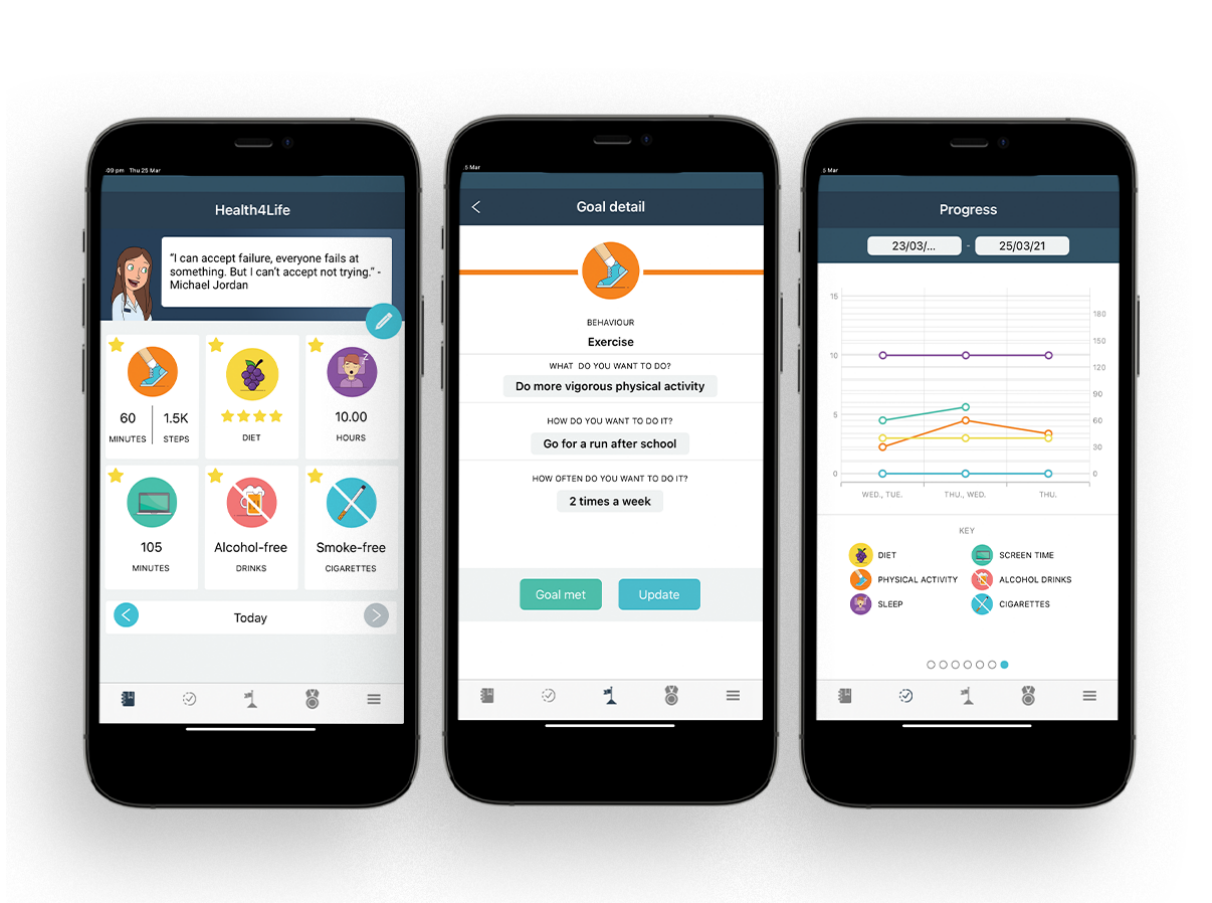
Figure 1. Selected screenshots of the Health4Life